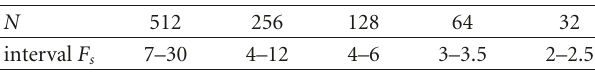
Table 4: The appropriate range for F s = F H using Hermite functions as multitapers optimal to LSP for di ff erent values of N